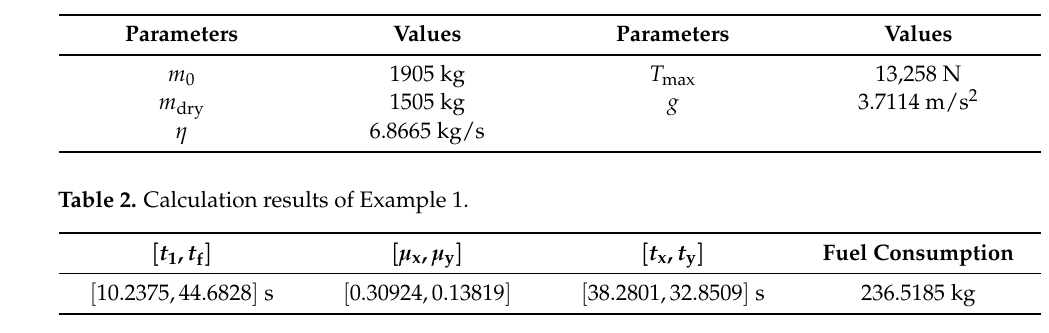
Table 1. Parameters of Example 1 (SI units).